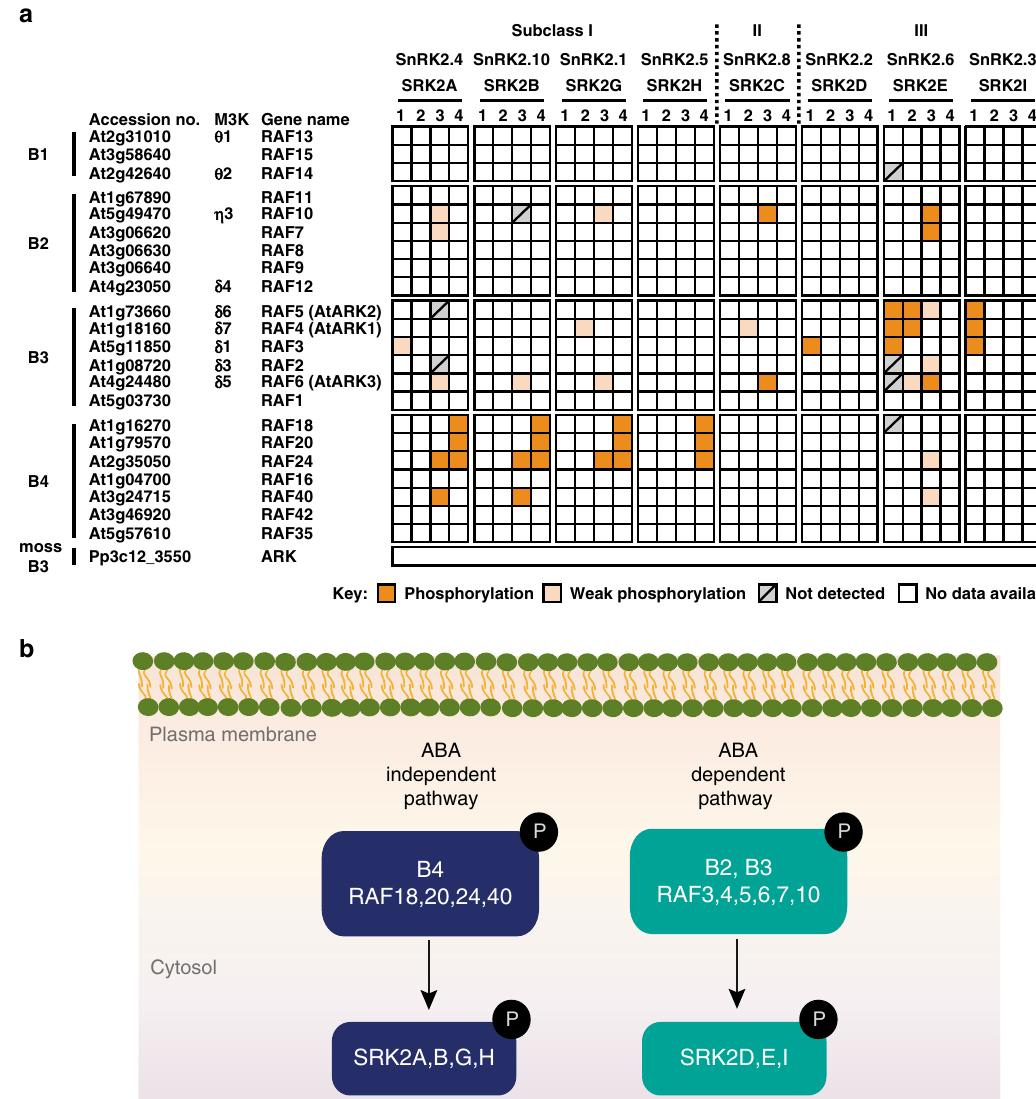
Fig. 2 Subgroup B Raf-like MAPKKKs and their substrate speci fi cities for SnRK2 kinases. a Heat map shows the in vitro phosphorylation of SnRK2 kinases by Raf-like MAPKKKs of Arabidopsis and P. patens . Arabidopsis SRK2J (subclass I) and SRK2F (subclass II) were excluded due to no data available. According to the phylogenetic tree 33 , PpSnRK2B belongs to subclass III SnRK2s. 1 , Takahashi et al. 51 ; 2 , Katsuta et al. 54 ; 3 , Lin et al. 52 ; 4 , Soma et al. 53 ; 5 , Saruhashi et al. 50 . Please also refer to Supplementary Tables for the accession numbers and the gene names. The accession numbers of P. patens genes: ARK, Pp3c12_3550 (in the P. patens genome v.3.3), also referred to as Pp1s462_10V6 or Phypa_30352; PpSnRK2B, Pp3c6_16600, also referred to